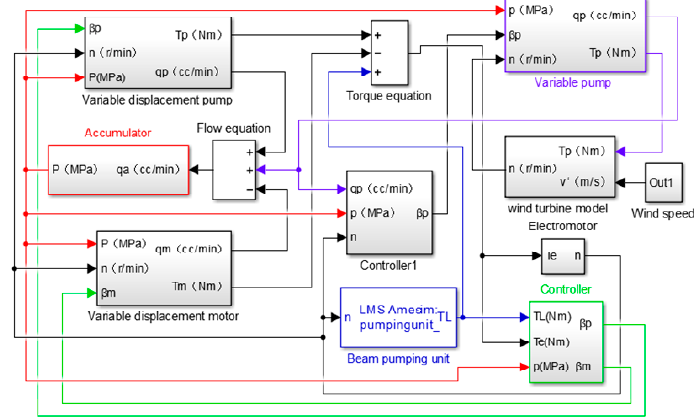
Figure 5. Wind-motor hybrid power pumping unit model.